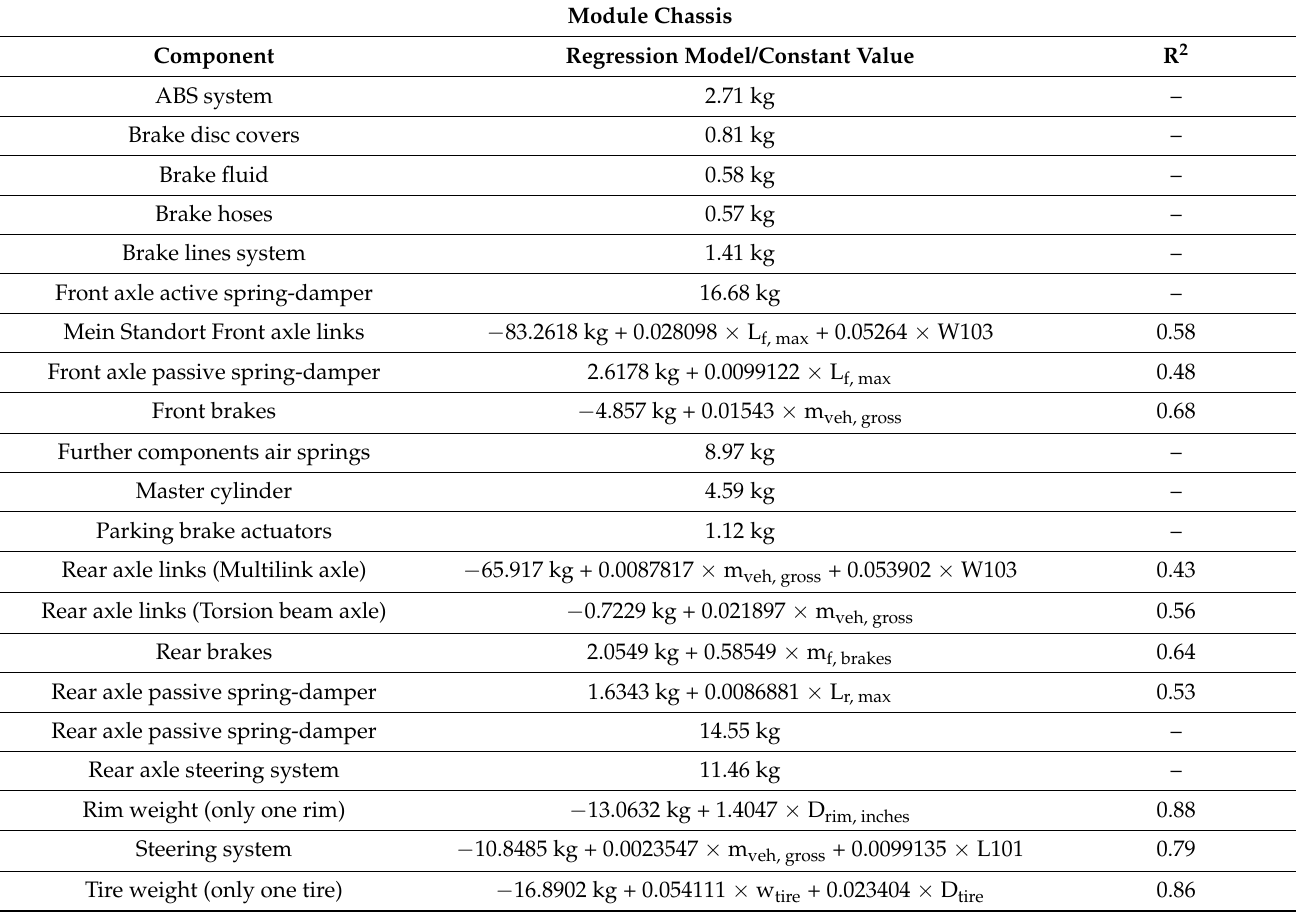
Table A4. Empirical models for the Chassis module.